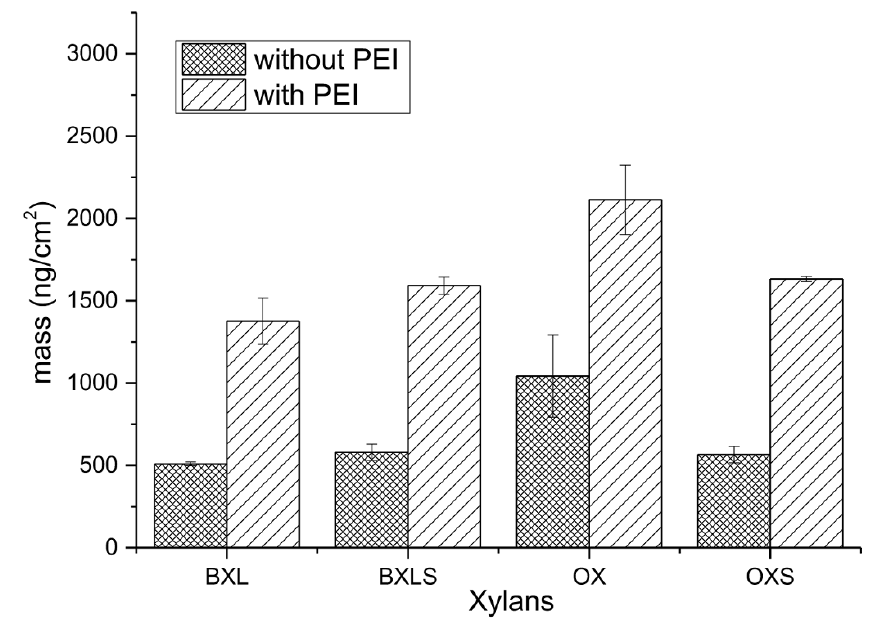
Figure 6. Calculated adsorbed mass of non-modified and sulfated xylans after rinsing with and without preliminary adsorbed PEI as an anchoring agent.